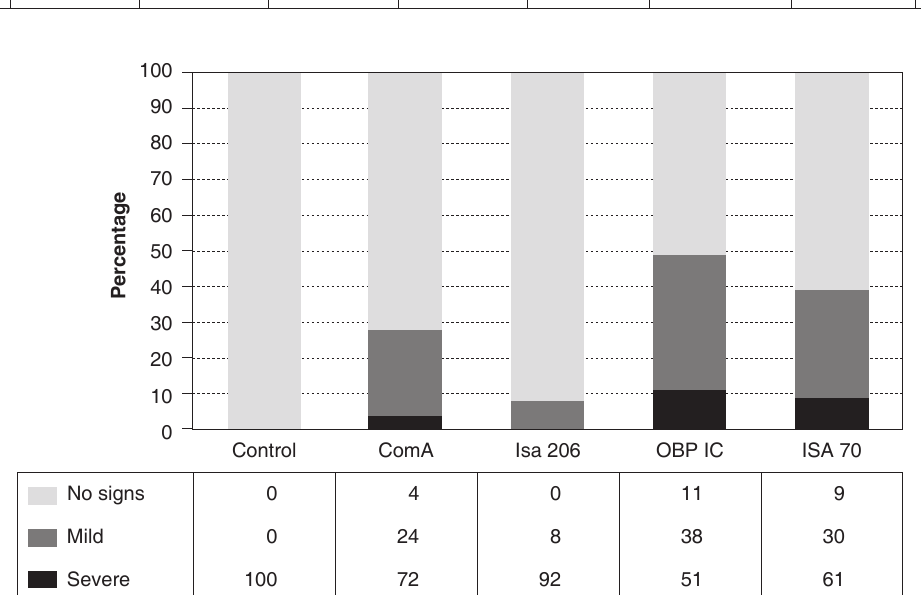
Graphic representation of the percentage of vaccination reactions obtained after the first vaccination with the different vaccines used in this experiment